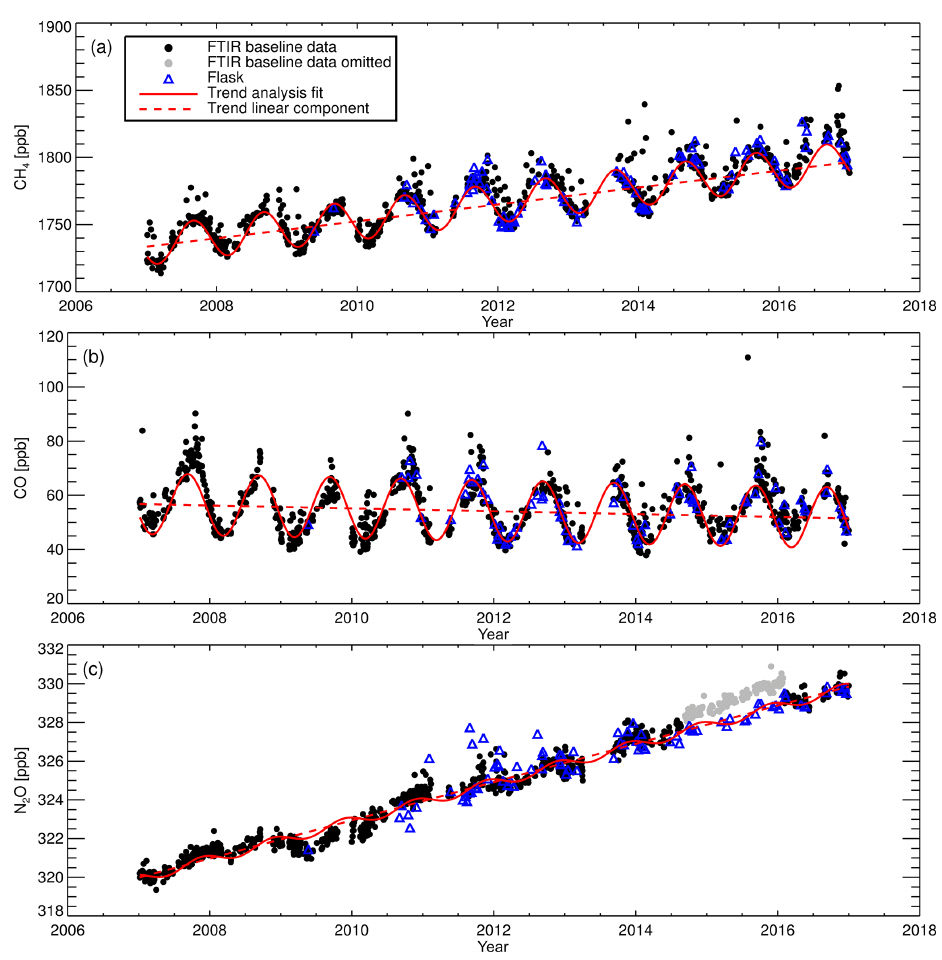
Figure 15. (a) Baseline CH 4 , (b) CO and (c) N 2 O FTIR measurements and flask samples. The FTIR trend analysis fit and the trend analysis linear fit component are plotted over in